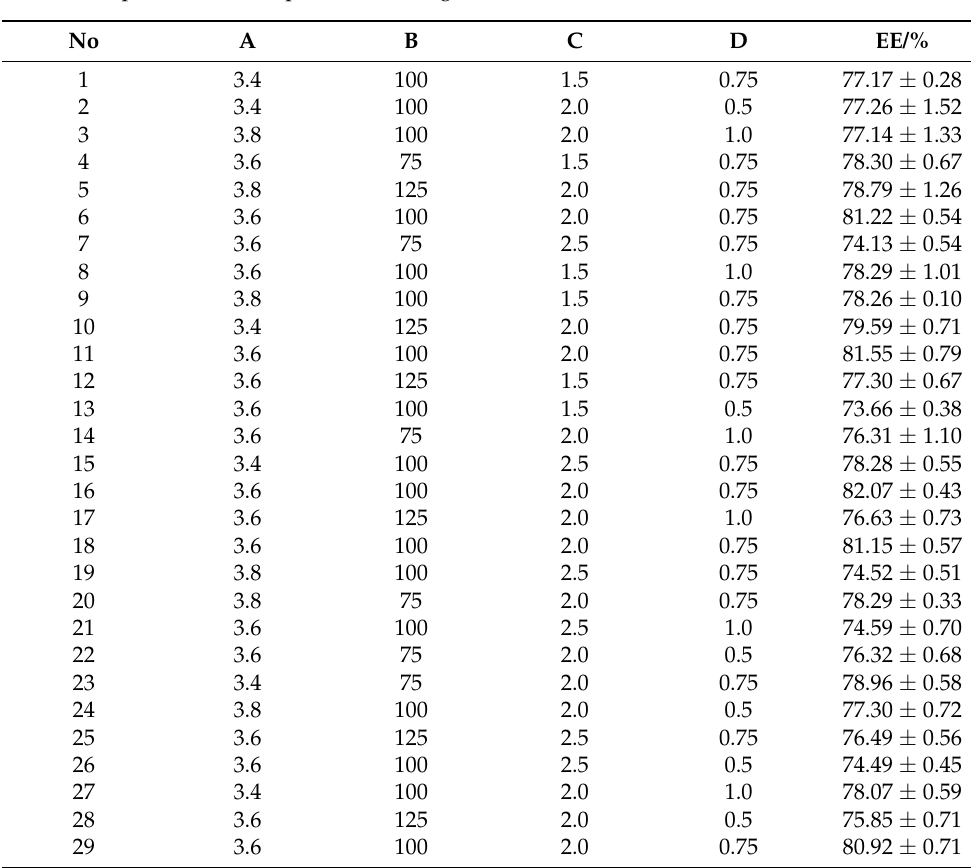
Table 7. Response surface experimental design and results.